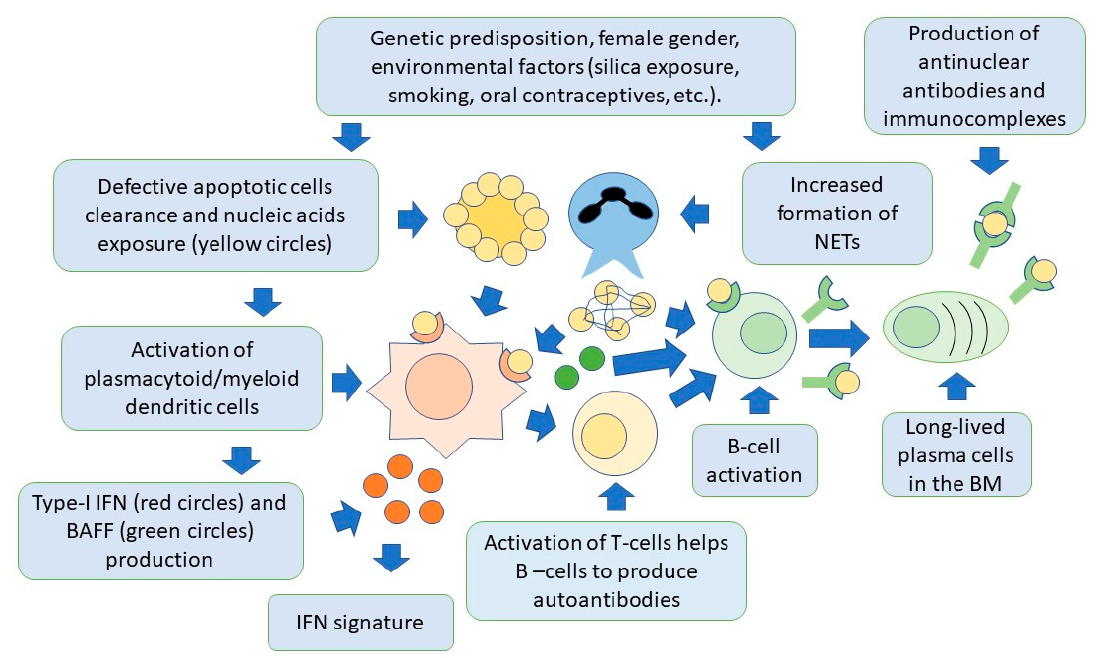
Figure 2. Both innate and adaptive immunity participate in the pathogenesis of SLE. In individuals with a genetic predisposition, and with the contribution of environmental factors, there is an accumulation of apoptotic cells and activation of NET production, by neutrophils. Cell nucleic acids are then exposed to the immune system and activate dendritic cells via toll-like receptors, to produce type-I IFN. This cytokine is responsible for activation of specific genes for pro-inflammatory factors by target cells (IFN signature). Dendritic cells also produce BAFF, which is necessary for B-cell activation and survival, and activate T cells, through the presentation of nuclear self-antigens. Self-reactive B cells are then activated to produce antibodies, and differentiate into long-lived plasma cells, localized in niches in the bone marrow, which are an additional source of autoantibodies. Autoantibodies form immunocomplexes with specific nuclear self-antigens that precipitate in tissues, contributing to organ damage.